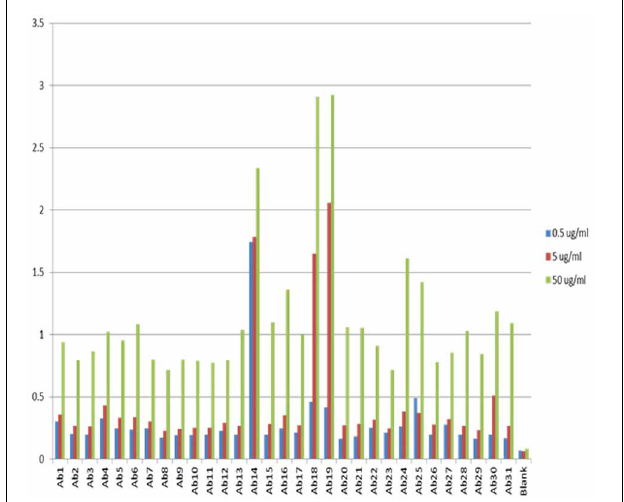
FIGURE 3 | Sensitivity of the antibody array ELISA at different mAb concentrations. The sensitivity of the antibody array ELISA could be adjusted from the concentration of mAb used. If the intension is to detect an even smaller population of mAb with defined epitope exposure, a higher mAb concentration could be used such as 50 μ g/ml. On the other hand, if it is a preliminary testing of surface epitope exposure, a low mAb concentration could be used such as 0.5 μ g/ml. The standard recommended mAb concentration for testing is 5 μ